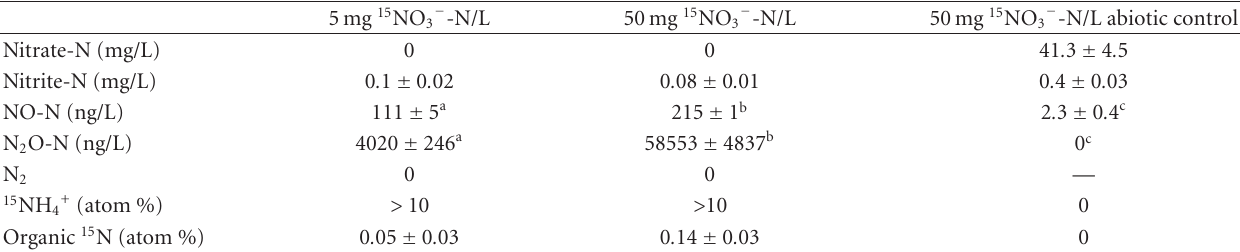
Table 1: Nitrogen concentrations measured after 24 hours of anaerobic incubation of fecal microbiota in feed medium supplemented with K 15 NO 3 (10 atom %). The N 2 concentration measured in the control is subtracted from the concentrations measured in the samples. 15 NH 4+ and organic 15 N are recovered from K 15 NO 3 (10 atom %). Results are means ± standard deviation of 3 incubations of fecal suspension from 1 representative